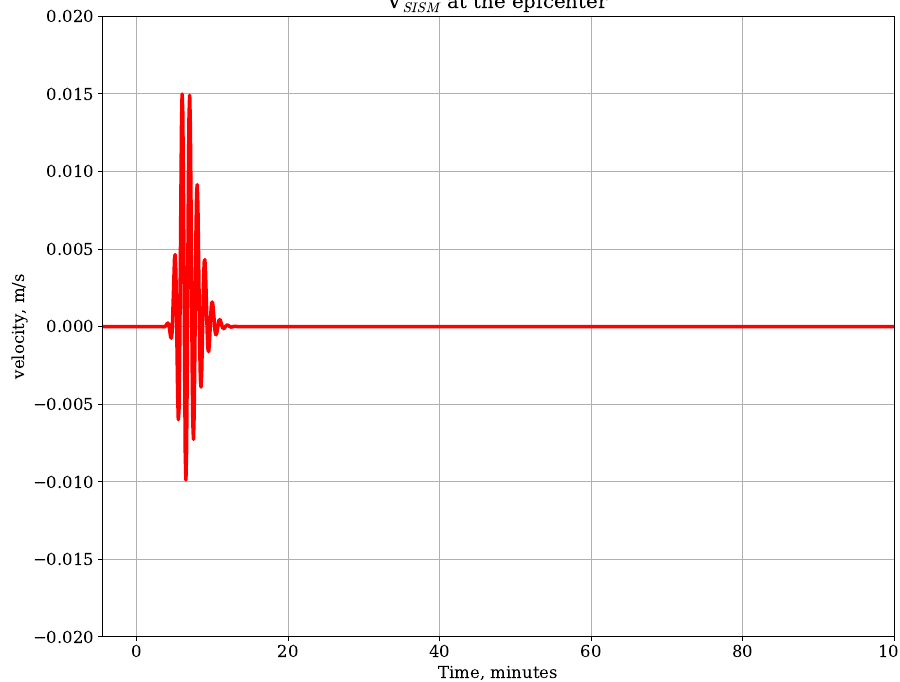
Figure 1. The ground vertical velocity V SISM associated with the earthquake of magnitude 8 (Here the seismic waveform of 2008 Wenchuan earthquake is considered).